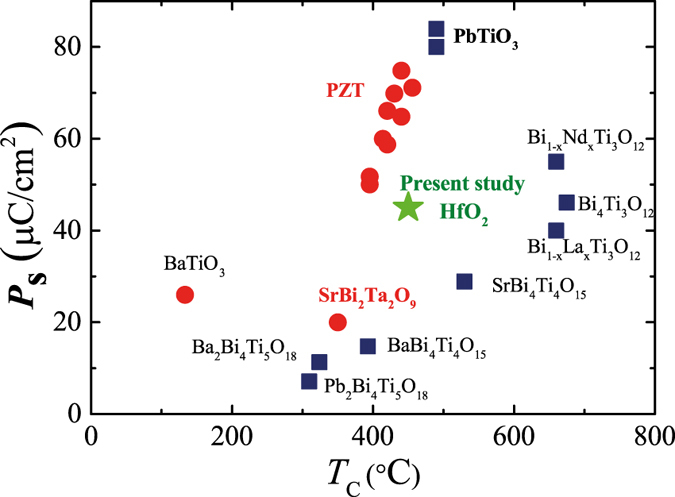
Relationship between the Curie temperature (TC) and spontaneous polarization (Psat) for conventional ferroelectric materials and the present YHO-7 film. The materials include BaTiO3 4748, PbTiO3 53, PbZr1−xTixO3 5054, SrBi2Ta2O9 49, Pb2Bi4Ti5O18 55, Ba2Bi4Ti5O18 55, BaBi4Ti4O15 55, Sr2Bi4Ti4O15 56, Bi4Ti3O12 5758, Bi4−xLaxTi3O12 5960, and Bi4−xNdxTi3O12 4361.